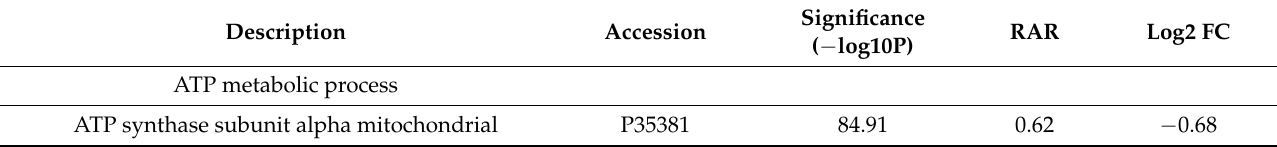
Figure 6. Representative heatmap of mitochondrial proteins with decreased abundance (RAR < 0.67) in response to one week of exercise in D. melanogaster ( n = 3). Red-to-blue colour gradient represents high-to-low relative protein abundance. Proteomic analysis was conducted using label-free mass spectrometry. All proteins listed were classified as significant as per the criteria described in the results. Table 3. Proteins identified from the mitochondrial fraction with decreased expression in response to exercise, with Gene Ontology biological process enrichment, as determined by STRING database v.11.0. analysis. Enrichment of a diverse range of metabolic processes was identified among the proteins with decreased expression. RAR: relative abundance ratio; FC: fold